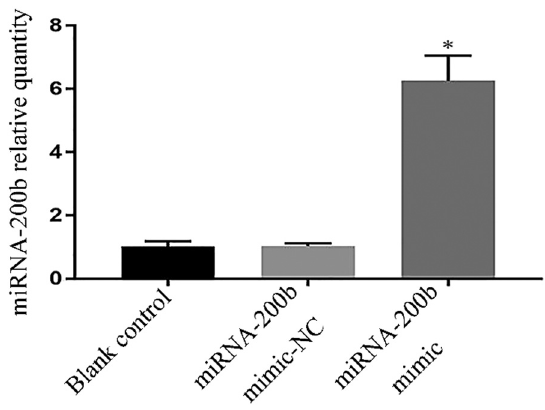
Figure 1: Comparison of miRNA - 200b expression levels in each group. Note: compared with blank control group and mimic - NC group, * P <